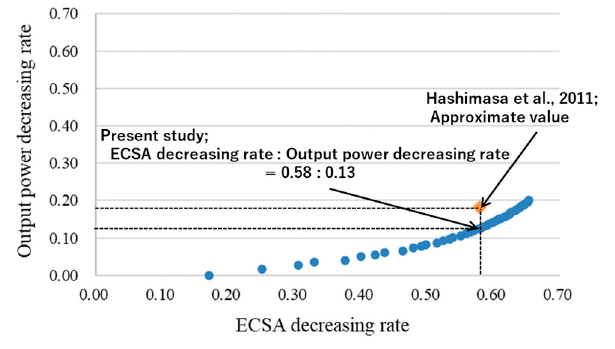
Figure 8. Effects of ECSA decrease rate on output power decrease rate [51].